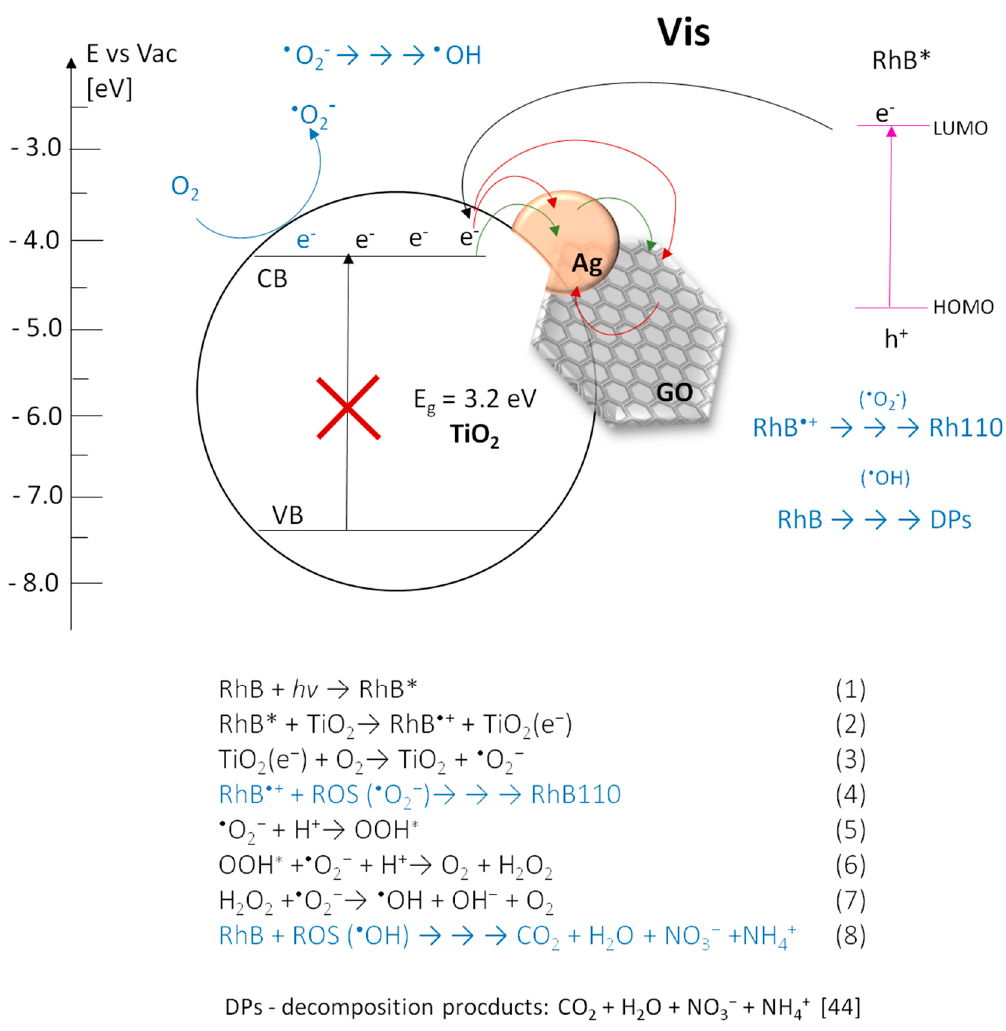
Figure 13. The reaction path [22,44,55,63] and possible photocatalytic mechanism of the three-component systems with different surface architecture occurring for photocatalysis of RhB performed under Vis radiation. Green arrows correspond to the flow of electrons in TiO 2 -AgNS-GO composite. Red arrows correspond to the flow of electrons in TiO 2 -(GO-AgNS) and TiO 2 -GO-AgNS composites.